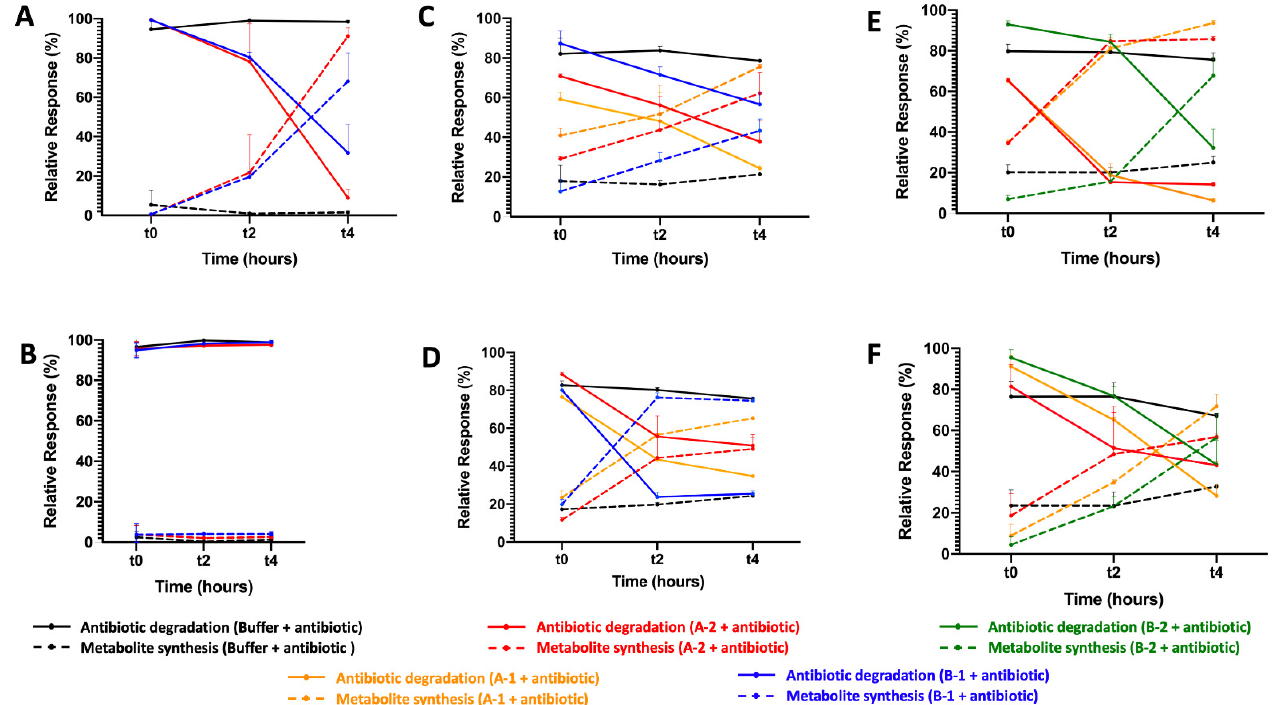
Figure 1. Enzymatic test of CPR putative beta-lactamases measured by LC-MS. ( A ) Beta-lactamase activity test against penicillin G in the absence of clavulanic acid, ( B ) and in the presence of clavulanic acid. ( C ) Beta-lactamase activity test against amoxicillin in the absence of clavulanic acid, ( D ) and in the presence of clavulanic acid. ( E ) Beta-lactamase activity test against ampicillin in the absence of clavulanic acid ( F ) and in the presence of clavulanic acid. Only CPR putative beta-lactamases that degrade beta-lactam substrates were shown.